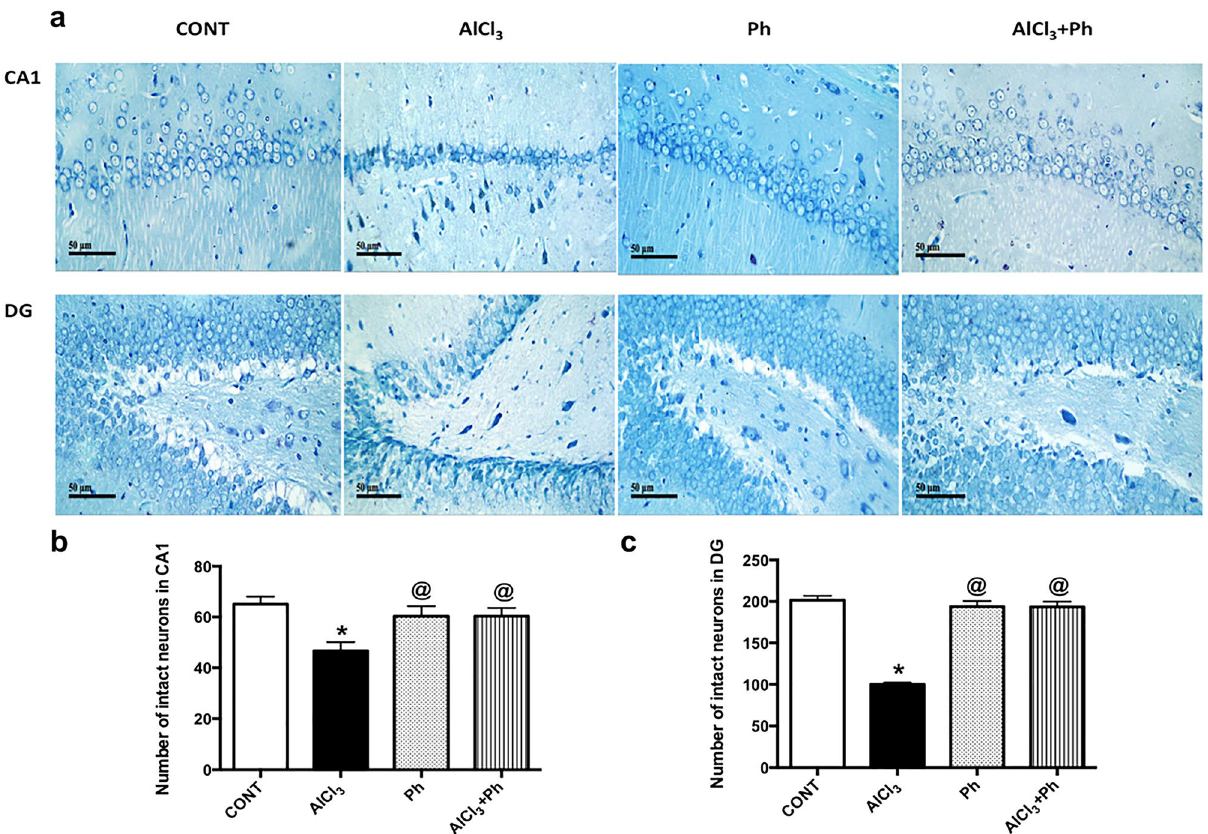
Figure 5. Effect of P. harmala on AlCl 3 -induced neuronal loss in hippocampal CA1 and DG regions. ( a ) Representative images of Nissl staining across hippocampal CA1 and DG sections (scale bar 50 μm). The lower panel shows the effect of P. harmala treatment on the number of surviving neurons in hippocampal ( b ) CA1 and ( c ) DG regions. Values represent mean ± SD (n = 3). Statistical analysis was carried out by one-way ANOVA followed by Tukey’s Multiple Comparisons test. (*) Significantly different from CONT and (@) AlCl 3 groups at p < 0.05; AlCl 3 aluminum chloride, CONT control, CA1 cornu Ammonis 1, DG dentate gyrus, Ph Peganum